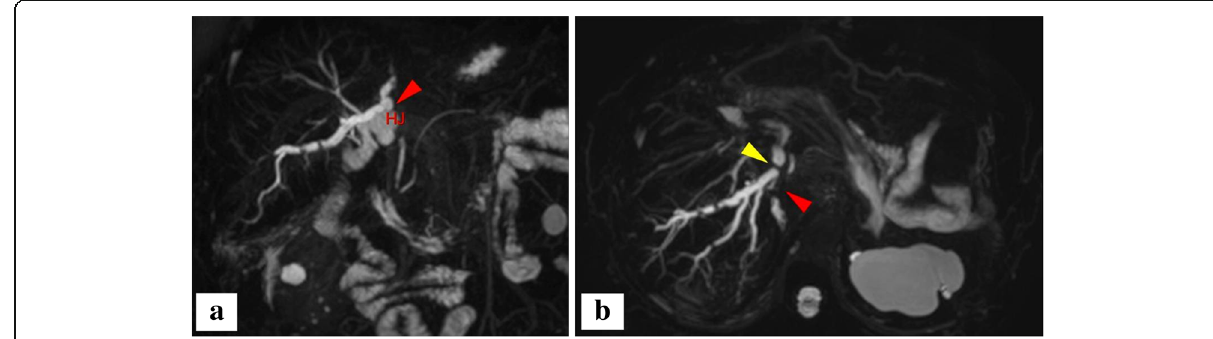
Fig. 4 A 60-year-old male 20 months after liver transplantation with hepaticojejunostomy (biliary-enteric anastomosis). MRCP 3D MIP reconstructed coronal ( a ) image showed the presence of anastomotic stricture (red arrowhead) and axial ( b ) image showed both anastomotic (yellow arrowhead) and intrahepatic stricture involving donor posterior bile duct (red arrowhead)